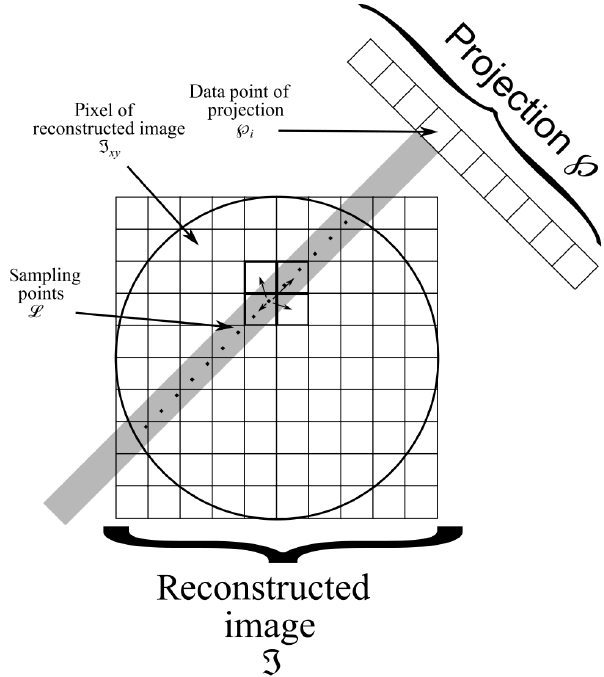
Figure 5. Scheme of our implementation of the SART algorithm (Andersen and Kak, 1984). A ray is cast from every data point of the projection ℘ into the image matrix I . Along this ray S values of the matrix elements (pixels) are sampled from I at locations L j ( j = 1 ...S ). Each point L j is computed as the weighted sum of the four closest points (pixels) of I